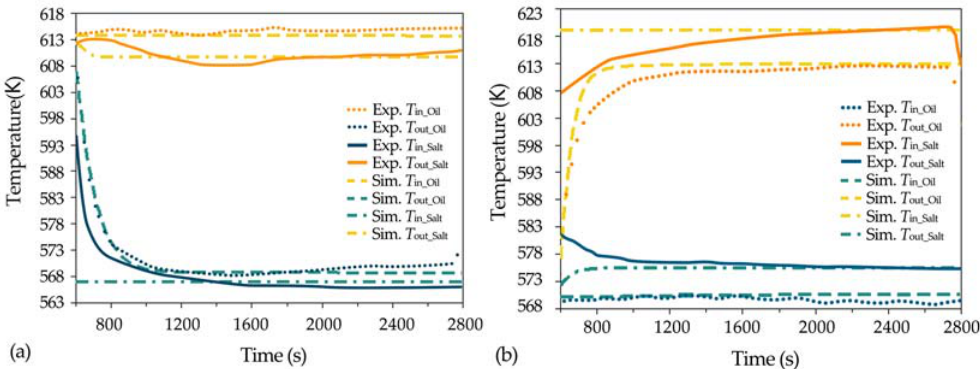
Figure 6. Temperature evolution along time of the synthetic thermal oil and molten salt at the terminals of the heat exchanger in a counter flow arrangement during: ( a ) charge process; ( b ) discharge